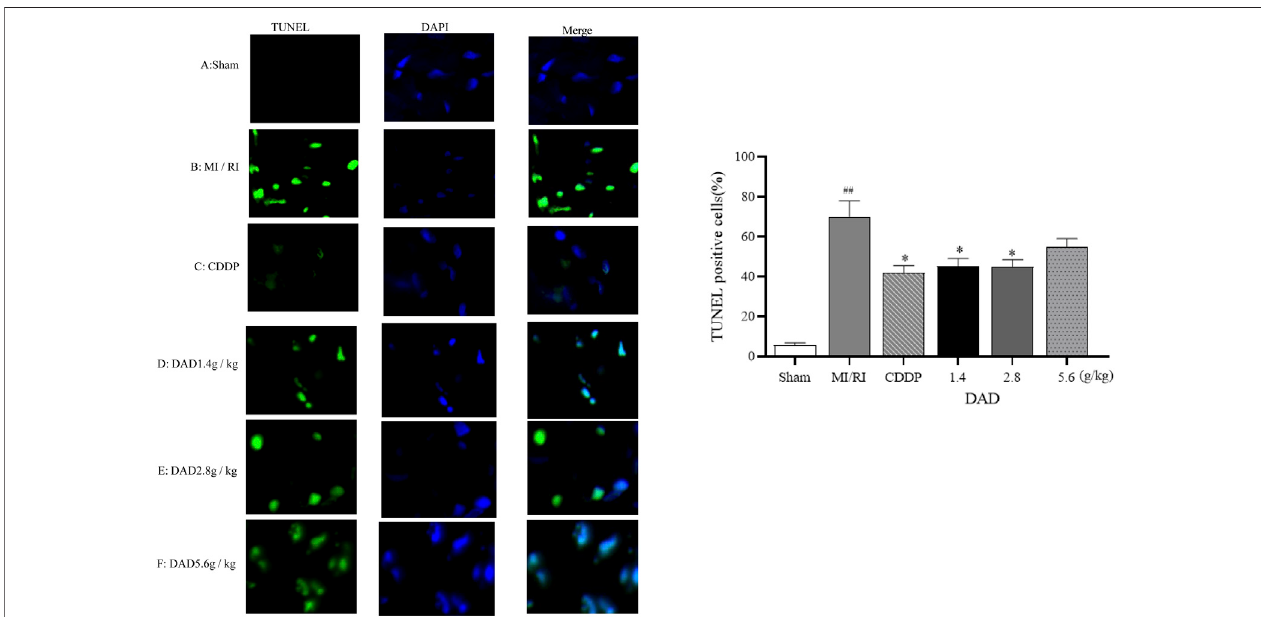
FIGURE 7 | Effects of dried ginger-aconite decoction (DAD) on apoptosis of myocardial cells in MI/RI rats. Apoptosis of cardiomyocytes (green) and DAPI (nuclei Blue).Representativeimageswereshown,andthescalebarindicated20 µm.Thepercentofapoptosiscellswerecalculatedforstatisticalanalysis.Datawerepresented as mean standard deviation (SD). # p < 0.05, ## p < 0.01 vs. sham group. * p < 0.05, ** p < 0.01 vs. MI/RI